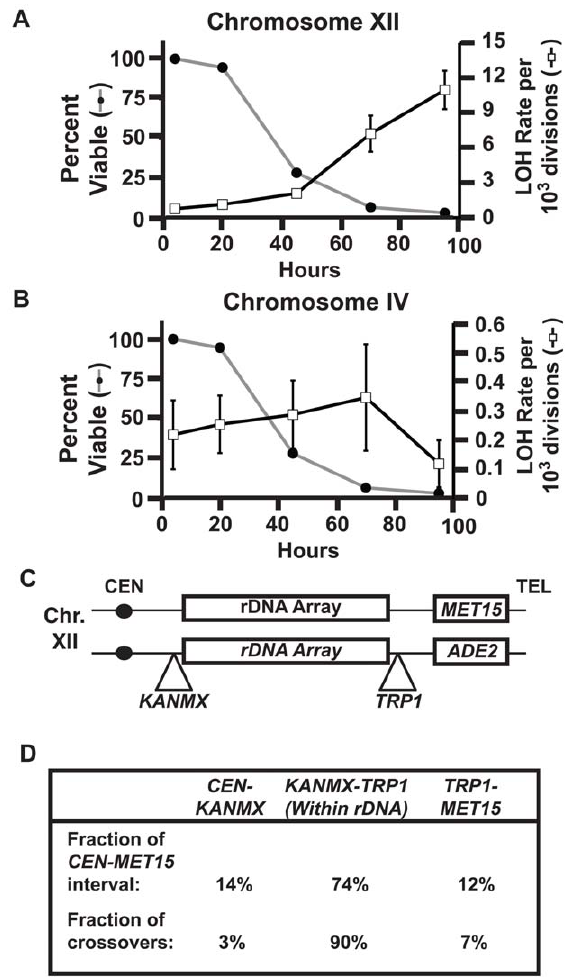
Figure 1. Age-associated LOH events are a result of recombi- nation within the rDNA array. A) Right y-axis: LOH rates at MET15 (open boxes) reported as total LOH events per cell division. Error bars indicate Standard Error of the Mean (SEM). Left y-axis: Percent viability of mother cells in the aging culture (grey line). B) Right y-axis: LOH rates at Chromosome IV (black line) reported as total LOH events per cell division. Error bars indicate SEM. Left y-axis: Percent viability of mother cells in the aging culture (closed circles). C) A schematic of marker placement on Chromosome XII used to determine homologous recombination break points. D) Table indicating the relative sizes of intervals between markers and the proportion of LOH events that originate within each